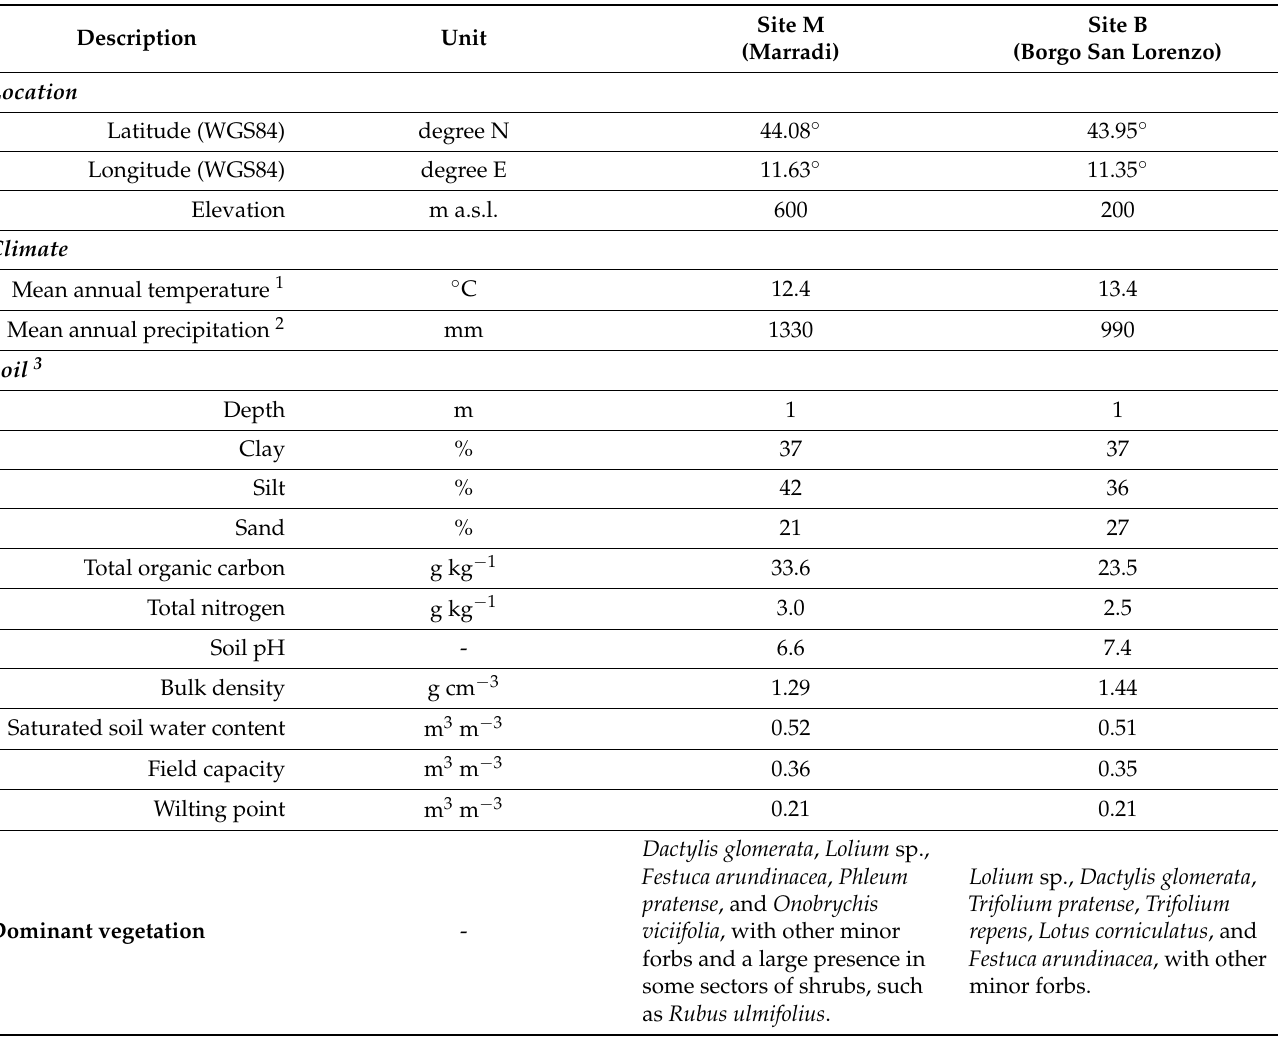
Table 1. Description of the study sites.